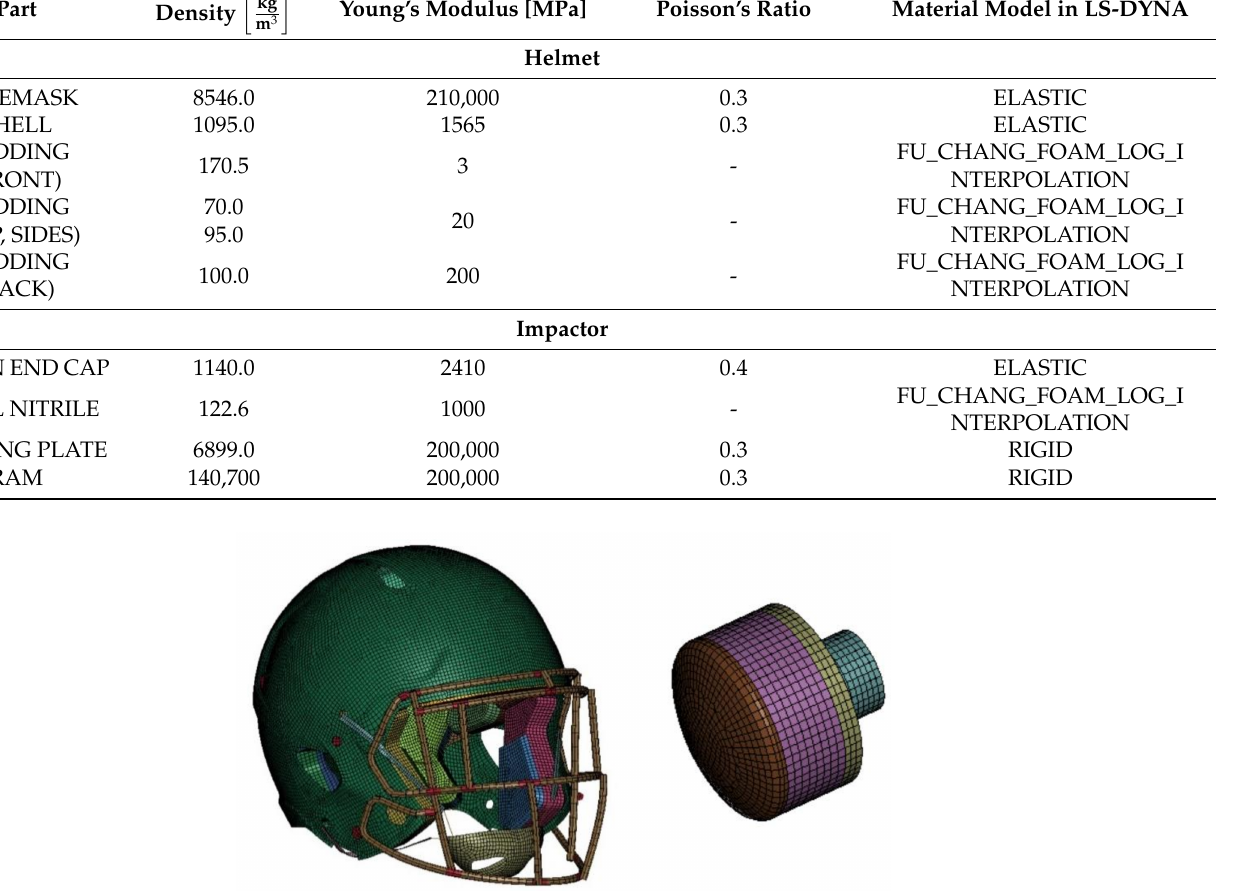
Table 3. Material properties of the helmet and impactor components [68].